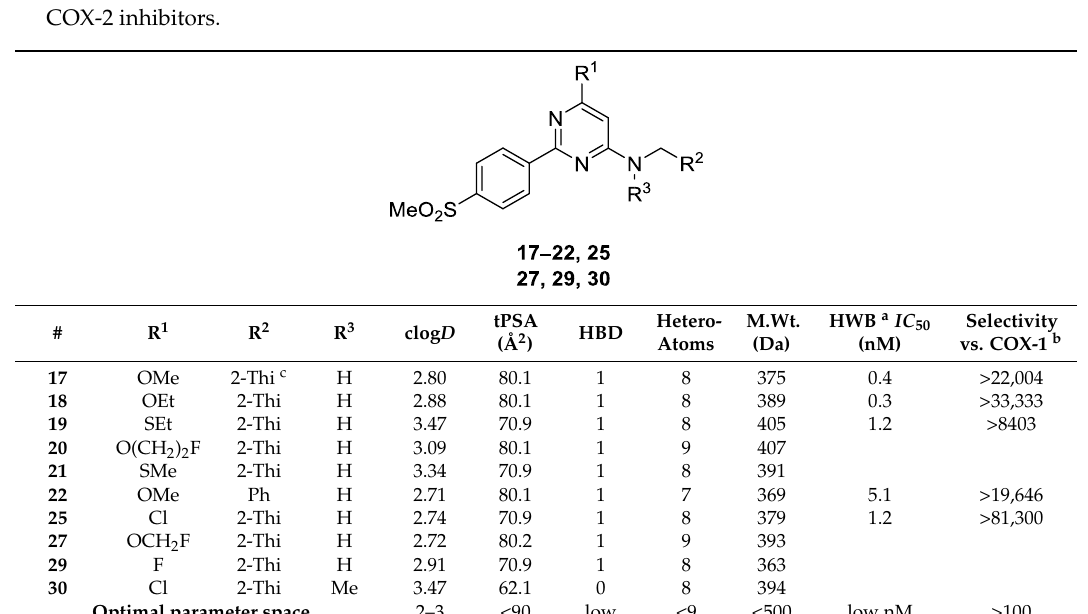
Table 1. Physicochemical, structural and previously reported pharmacological parameters for selected COX-2 inhibitors.